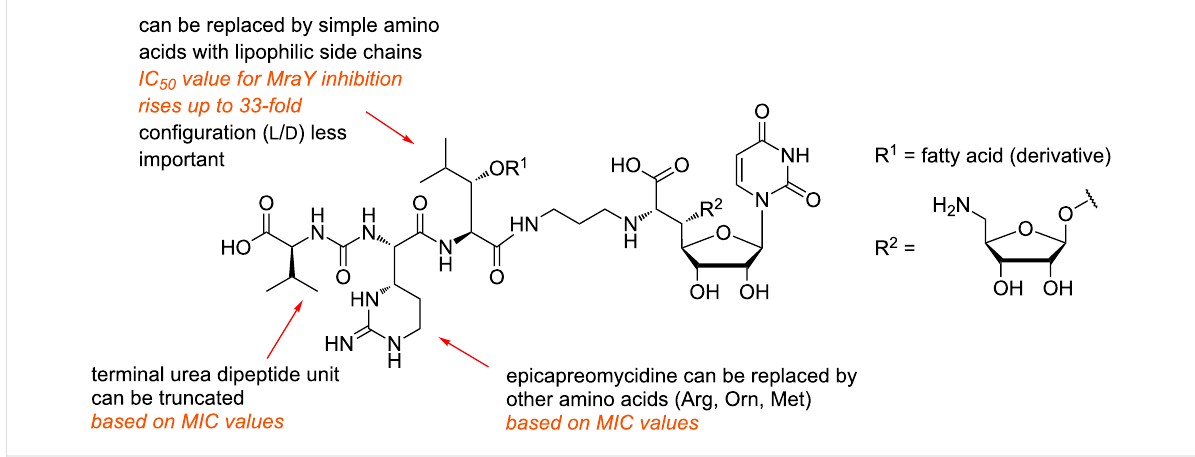
Figure 11: SAR results for several structural variations of the muraymycin scaffold.